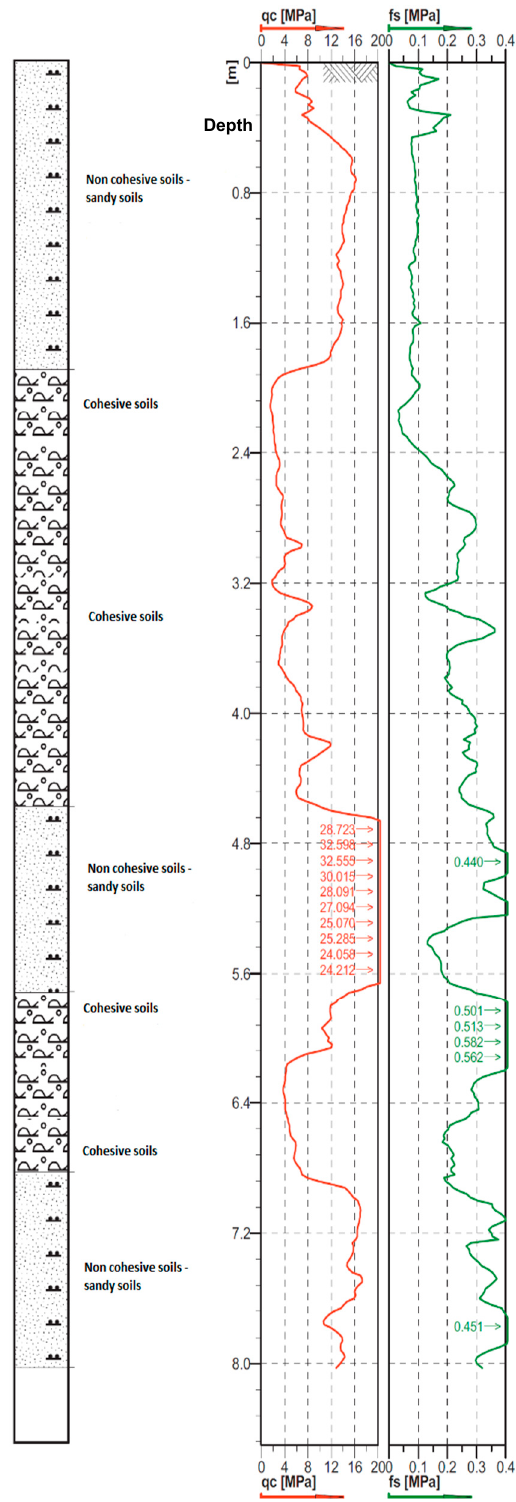
Figure 1. Example of q c and f s resistance values obtained based on the test conducted using the Cone Penetration Test Unit (CPTU) probe.